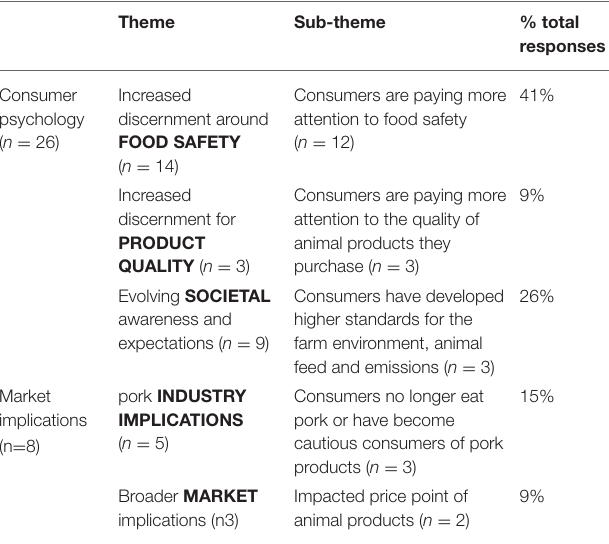
TABLE 6 | Themes derived from participants responses ( n = 34) to the item “in what way has consumer behavior changed in response to COVID-19?” by frequency with which the identified theme was reflected in the data, and the percentage of overall responses in the